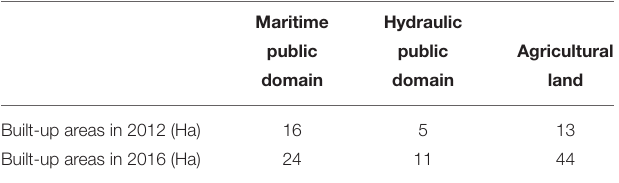
TABLE 5 | Quantification of urban expansion at the expense of agricultural land, Maritime public domain and Hydraulic public domain.